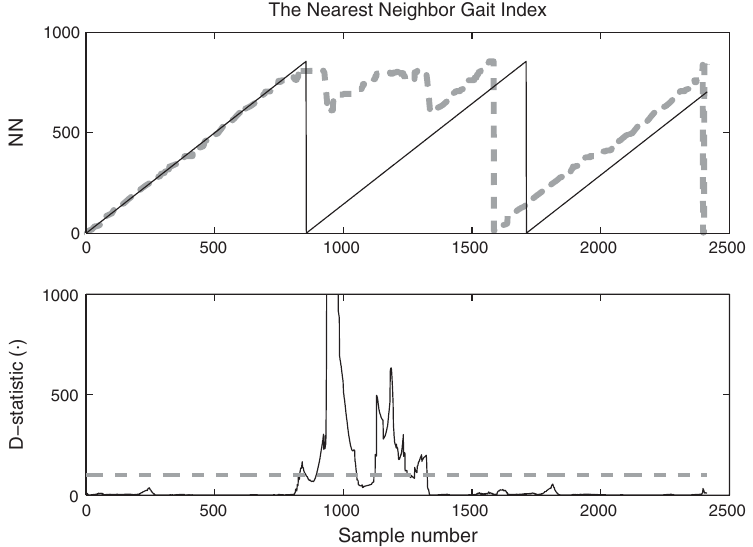
Fig. 8. Upper panel: the dahsed line represents the NN for push trial 3 (the robot kept walking) as provided by the NNGI. The solid line corre- sponds to the RLC, the dashed line to the NNGI. The lower panel shows the D-statistic (solid line) and the selected threshold D th (dashed line).